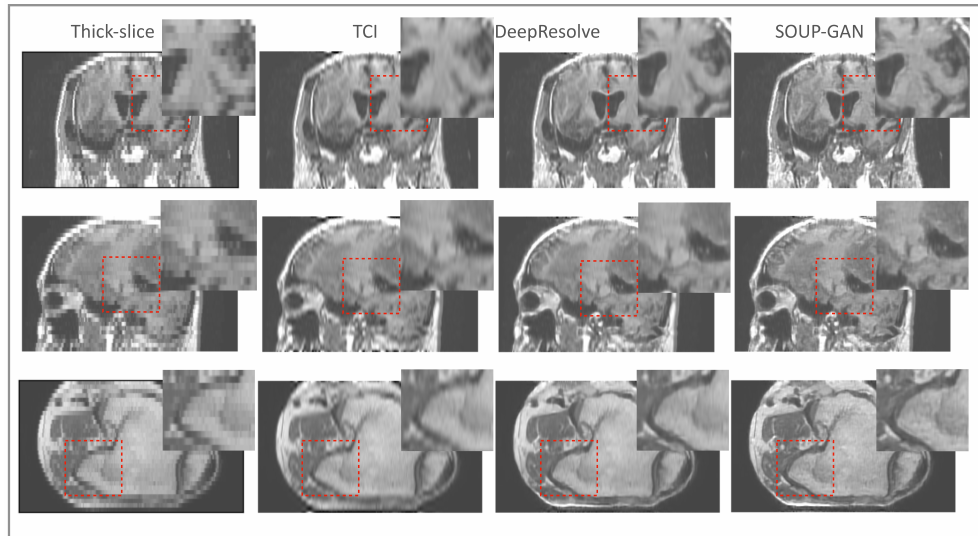
Figure 8. Ablation study: Test examples on brain and knee MRI showing perpendicular reconstruc- tions from original thick slices, using TCI, MSE, and GAN using 3D perceptual loss (SOUP). We note that [32] proposed a single-scale residual-based 3D convolutional neural network with MSE, similar to the third column here. Our SOUP approach better resolves the perceptual details and is more generally applicable to various sampling factors and different imaging modalities. TCI: tricubic